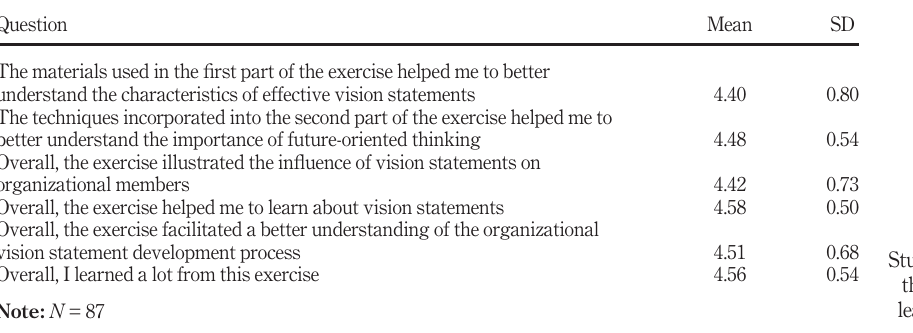
Table 2. Student reactions